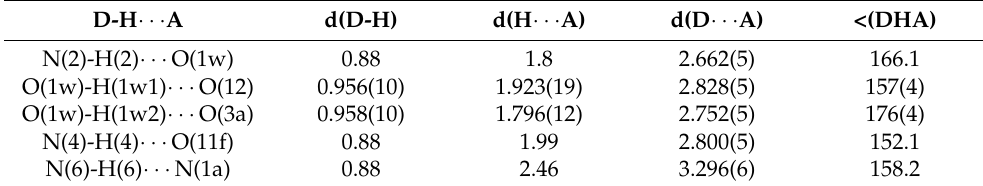
Table 3. Hydrogen bond distances (Å) and angles ( ◦ ) for 1 1,2